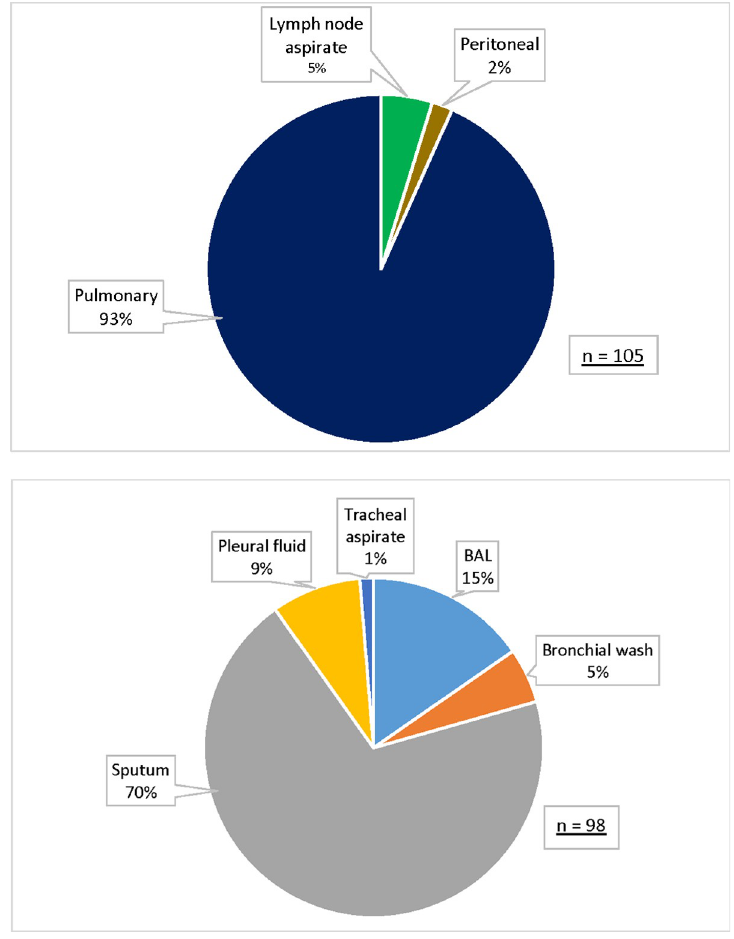
Fig 2. Source of MTB-positive specimens from Military Health System (MHS) and Veterans Affairs (VA) beneficiaries processed at Tripler Army Medical Center, 2002–2019. A. All MTB-positive specimens B. MTB- positive pulmonary specimens. Sources of all specimens: abscess, blood, body fluid, bone marrow, cerebrospinal fluid, gastric aspirate, lymph node aspirate, other (unspecified), pericardial fluid, peritoneal fluid, pulmonary, stool, synovial fluid, tissue, urine, and